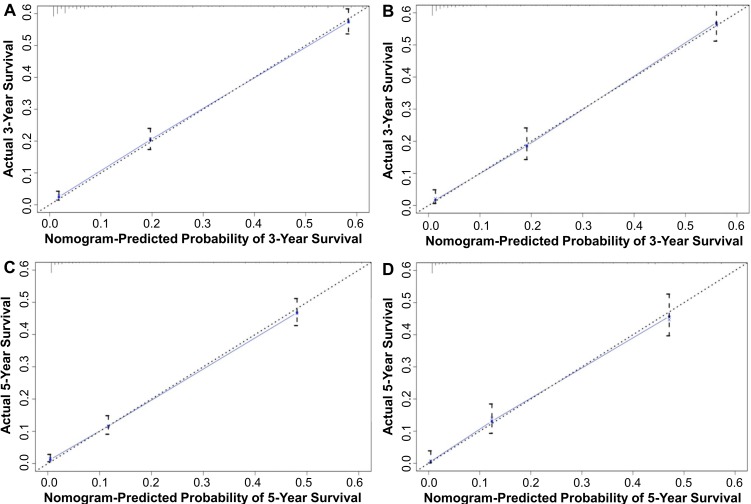
Calibration curves of the nomogram for predicting 3-year OS in the (A) training set and (B) validation set, and predicting 5-year OS in the (C) training set and (D) validation set. Nomogram-predicted OS is plotted on the x-axis and the actual OS is plotted on the y-axis. The diagonal dotted line indicates the ideal nomogram, in which the actual and predicted probabilities are identical. The solid line indicates the actual nomogram, of which a closer fit to the dotted line indicates a better calibration.